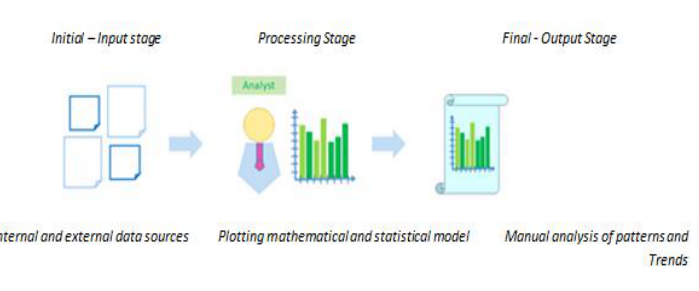
Fig. 1. Manual method of Analyzing Data